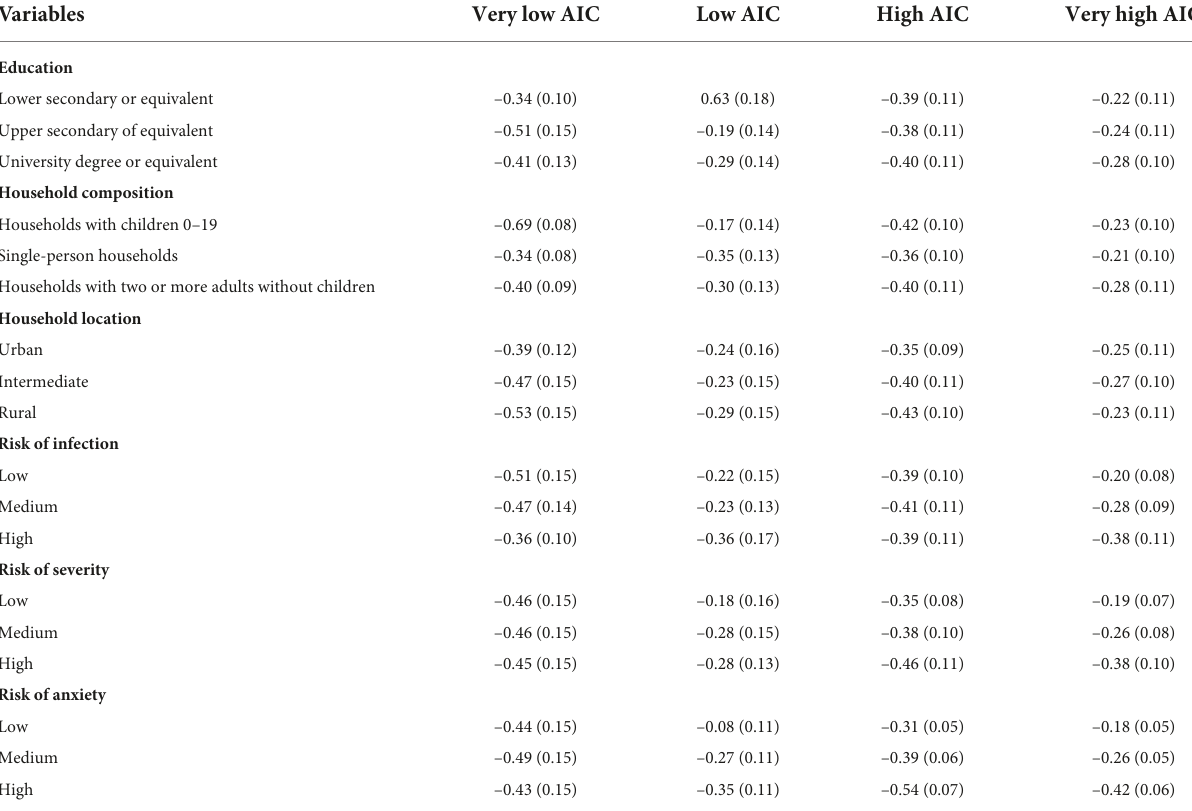
TABLE 9 Model post-estimates means ( SD ) for different AIC and individual household level effects describing the change in purchasing of food during the COVID-19